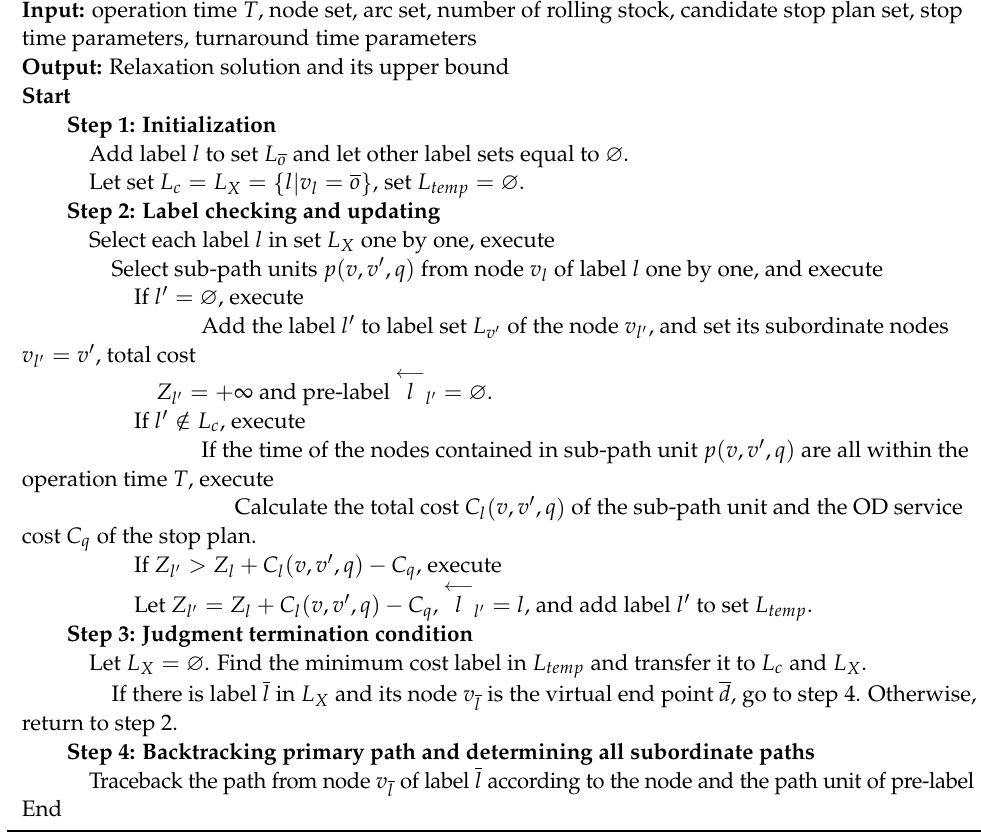
Algorithm 2: Single rolling stock shortest path search algorithm based on label idea